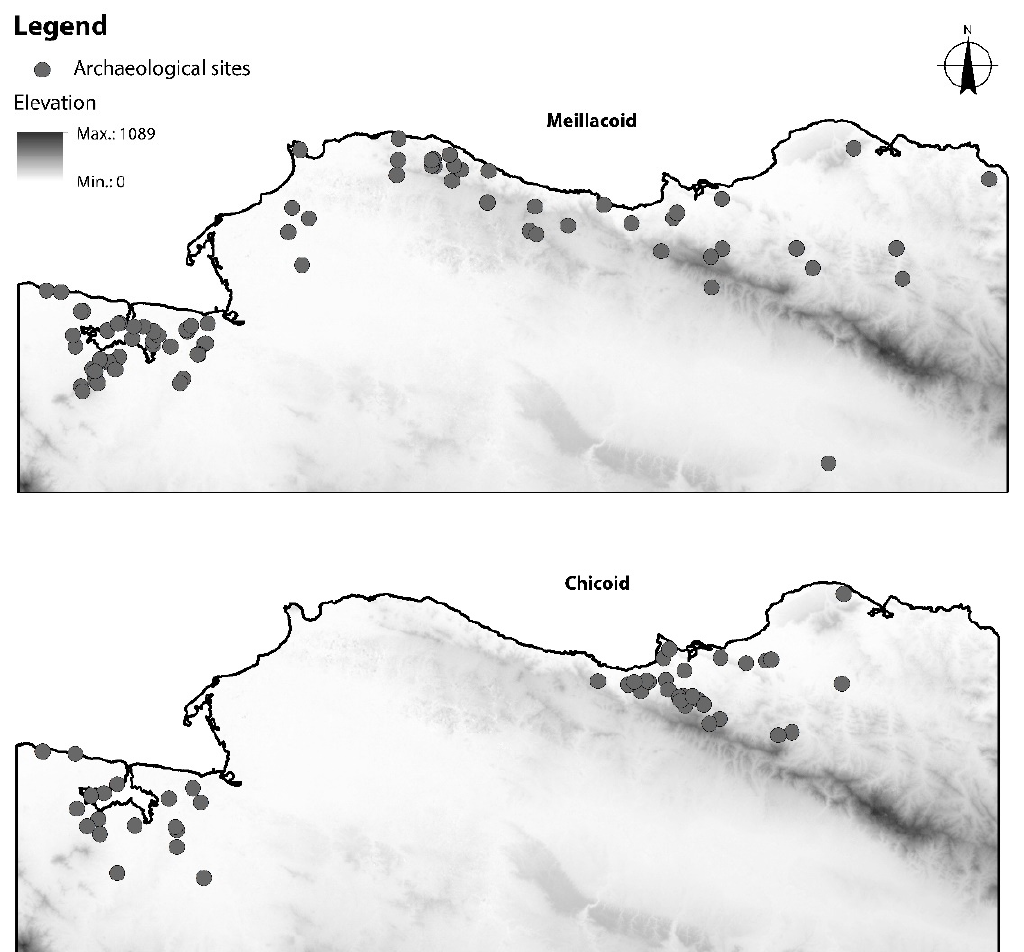
Figure 5. Large-scale taskscapes. Ceramic series distribution pattern: (above) Meillacoid, (below) Chicoid. The data for this image comes from [27,34–36].